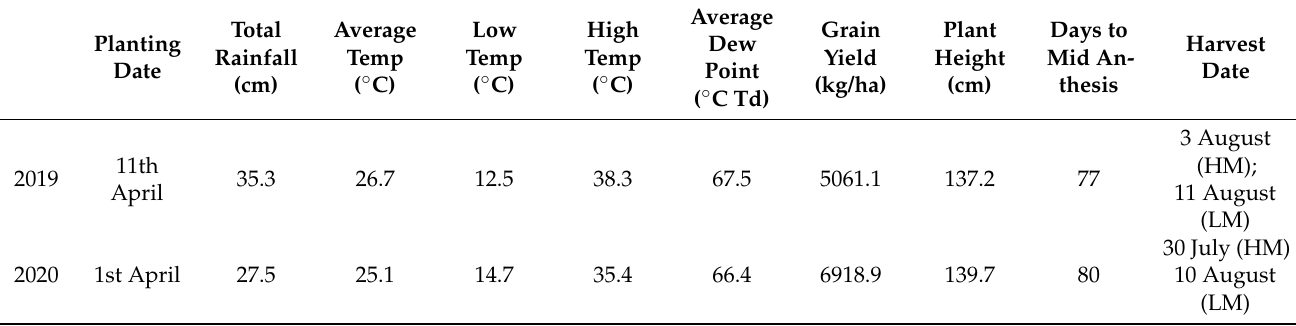
Table 1. Climatic and agronomic data for the grain of a Texas A&M pop sorghum hybrid grown in College Station, Texas in 2019 and 2020. Note: LM = low moisture and HM = high